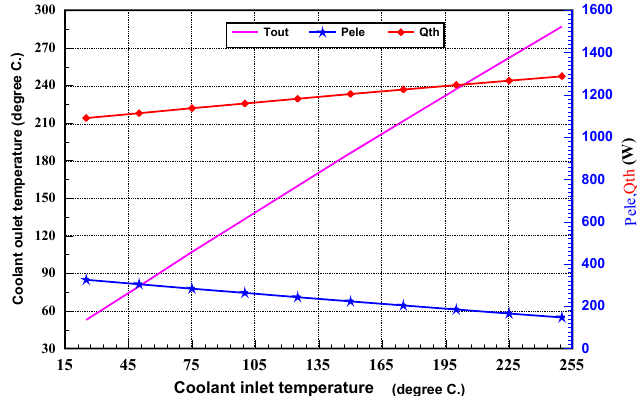
Figure 22. The variation of the CPV/T collector coolant outlet temperature, electric and useful thermal powers with the cooling inlet water temperature (constant ṁ = 0.01 kg/sec).